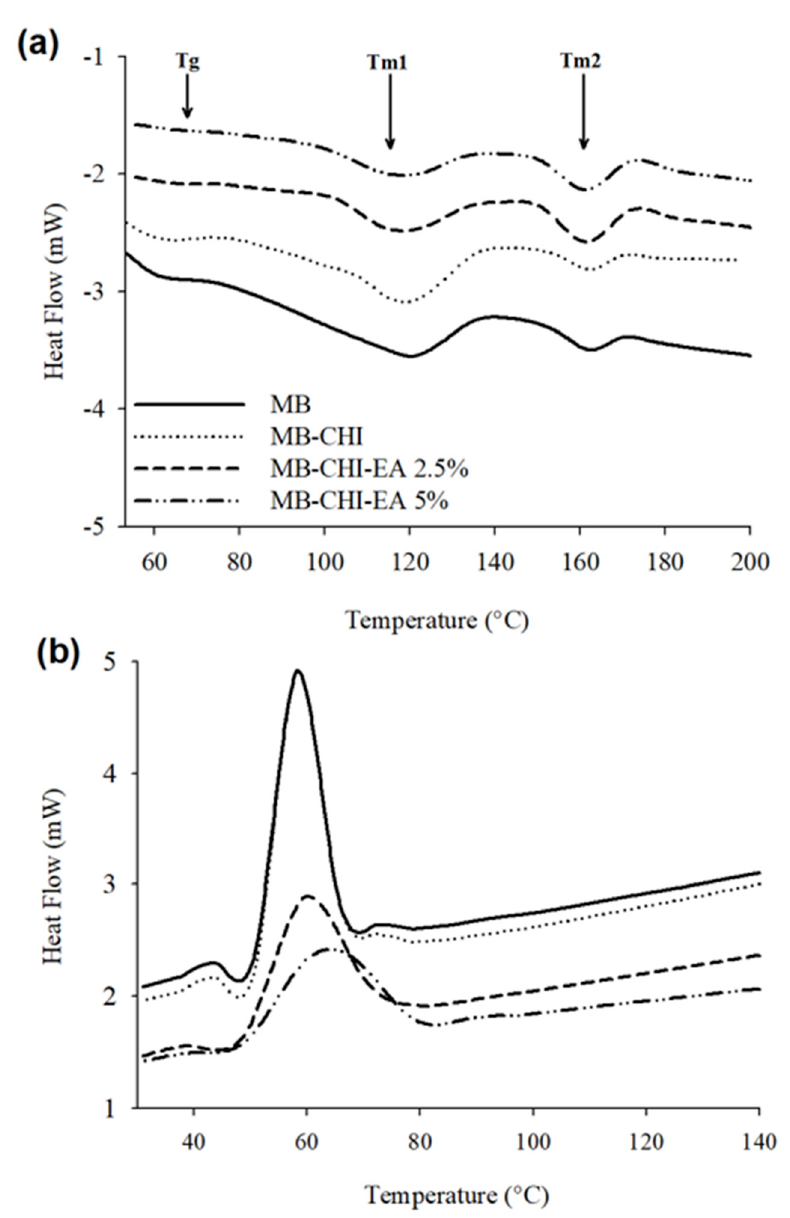
Figure 3. DSC thermograms during the ( a ) fi rst heating scan and ( b ) cooling scan for all